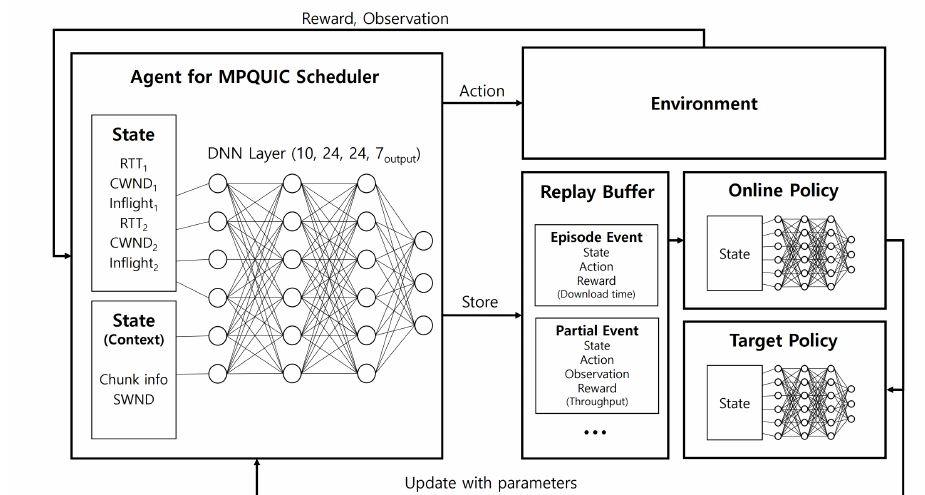
Figure 2. Deep-Q network (DQN)